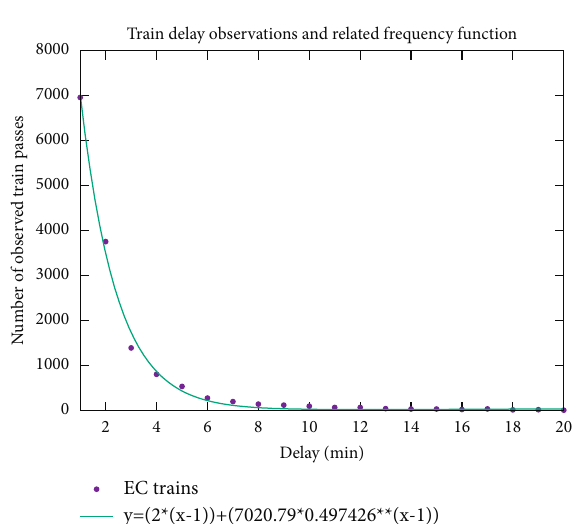
Figure 2: Example of an EC train category delay data histogram and related frequency function drawn as a continuous one to demonstrate its shape.